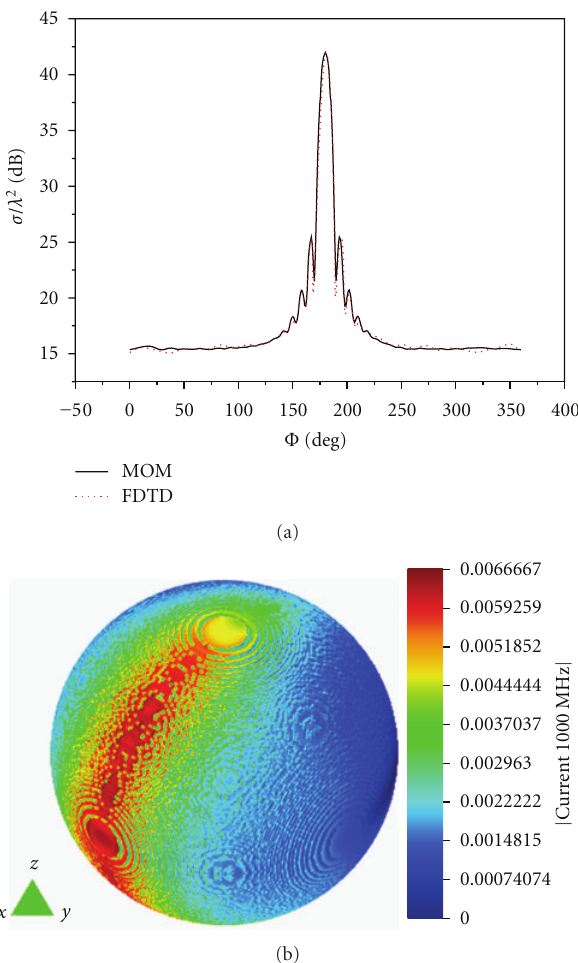
Figure 2: (a) Comparison of the RCS results in x o y plane obtained by FDTD and MOM; (b) current distribution over the surface of the